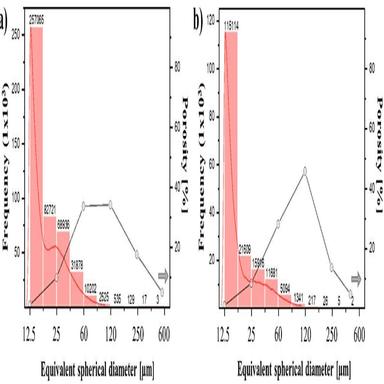
Histograms of the pore size distribution and porosity determined by µ-CT for a) monolithic and b) 3D-lattice samples. Pore size is indicated as the equivalent spherical diameter of the pores observed in and Fig. 7, respectively.